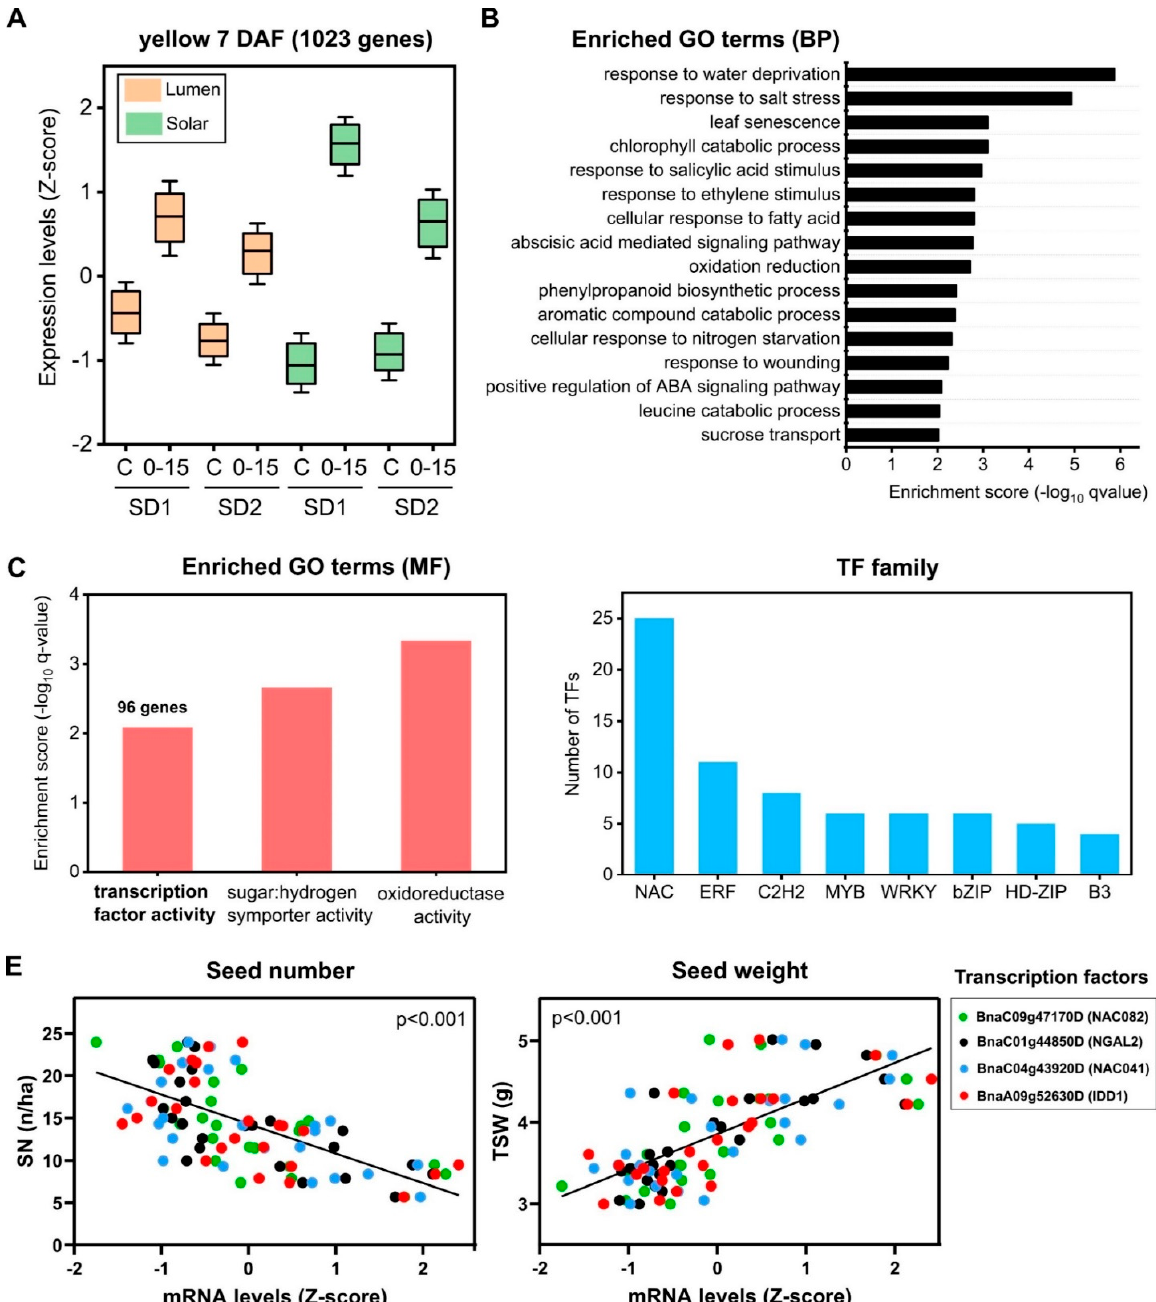
ship at 14 DAF. ( A ) A heatmap showing the module–trait associations. Each row corresponds to a module eigengene, and each column corresponds to a trait. Only significant correlations ( p -value < 0.01) are shown with numbers. Red and blue denote positive and negative correlations with gene expression, respectively. The agronomics traits were obtained from our previous work [16]. The modules significantly correlated with SW and SN are indicated with a black rectangle. ( B ) Histograms showing the number of genes (left) and GO terms (right) per co-expression module. Only modules signifi- cantly correlated with at least one agronomic trait are represented. ( C ) Balloon plot showing the percentage of genes in each module that are significantly regulated by each factor.